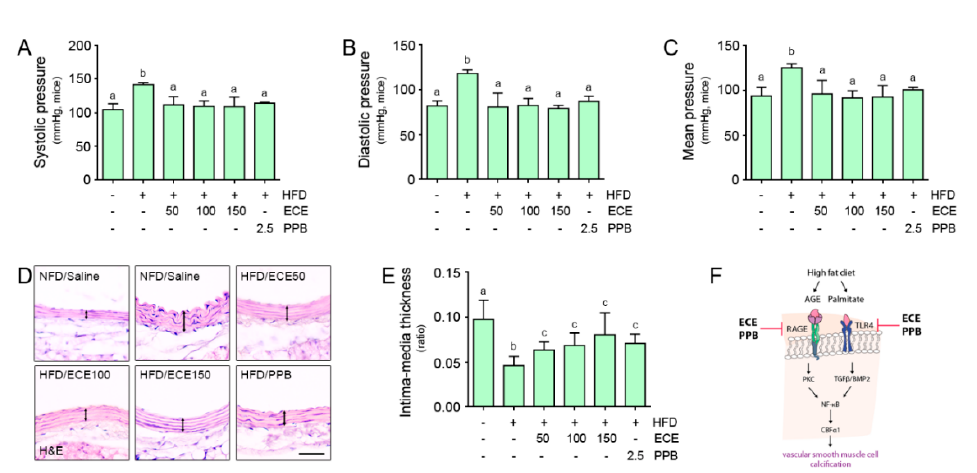
Figure 5. Comparative analysis of ECE and PPB administration on the regulation of blood pressure in HFD-fed mice. ( A – C ) Systolic, diastolic, and mean artery pressures were measured prior to sacrifice. ( D ) Light microscopic images showing H&E stained blood vessels and ( E ) Intima-media thickness acquired using representative H&E images. Arrows indicate media thickness. Scale bar = 50 µ m. ( F ) Summary illustration image showing inhibitory e ff ects of ECE and PPB on vascular smooth muscle cell calcification in HFD condition. Means denoted by a di ff erent letter indicate significant di ff erences between groups. AGE, advanced glycation end products; BMP2, bone morphogenetic protein 2; CBF α 1, core-binding factor alpha 1; ECE, Ecklonia cava extract; HFD, high-fat diet; H&E, hematoxylin and eosin stain; NFD, normal fat diet; PPB, pyrogallol-phloroglucinol-6,6-bieckol; NF- κ B, nuclear factor kappa-light-chain-enhancer of activated B cells; RAGE, receptor for advanced glycation end products; TGF β , transforming growth factor beta; TLR4, toll like receptor